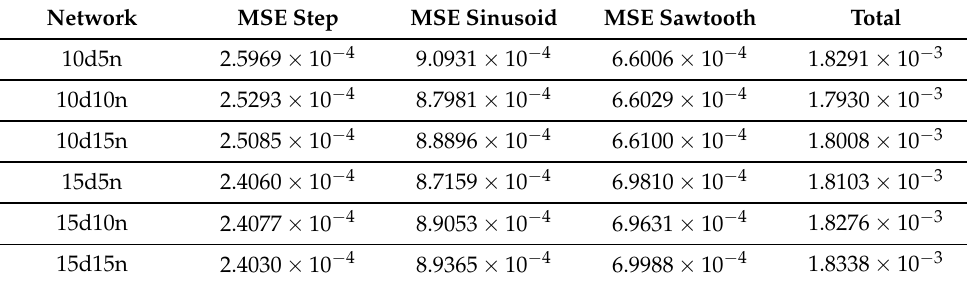
Table 7. MSE of the best identification networks for different references.